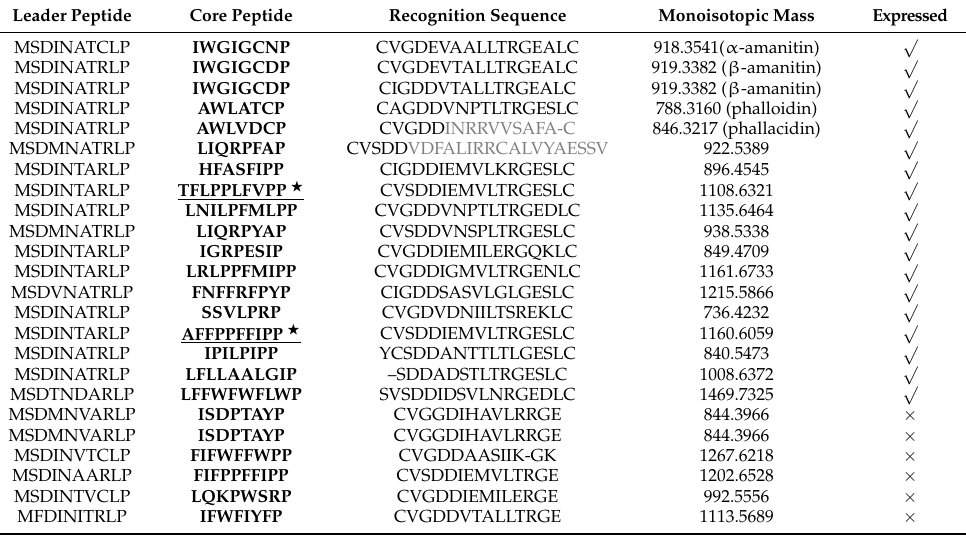
masses are for unmodified cyclic peptides based on MSDIN core peptides, except for major toxins ( α -amanitin, β -amanitin and phallacidin). Core peptides are indicated in bold. Table 3. Expression of the MSDIN gene family from Amanita